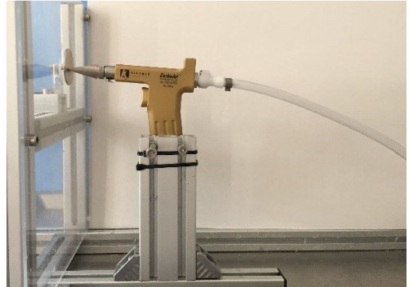
Figure 2. Force measuring plate with 2 mm distance to the CO 2